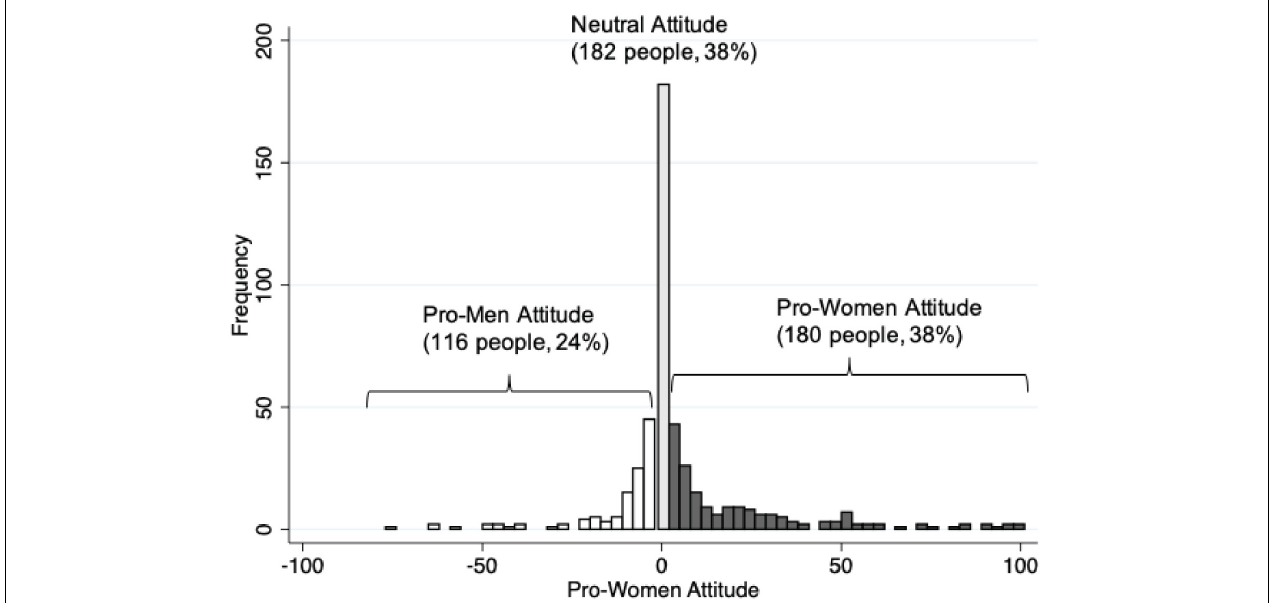
FIGURE 3 | Distribution of pro-women attitude. This figure shows the pro-women attitude of 478 respondents in the Qualtrics sample. The pro-women attitude of each respondent is the moral judgment about a manager who discriminates against a woman (on a –50 to +50 scale where higher values indicate more disapproval)